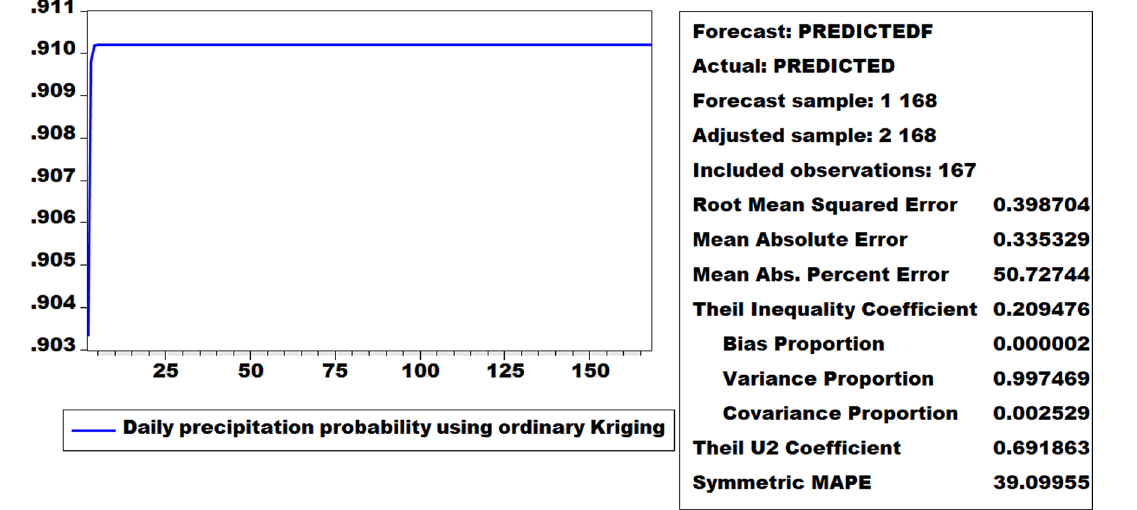
Fig. 10 The predicted data of daily rainfall based on the smoothed